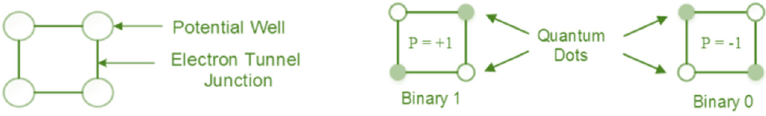
Figure 1. Basic QCA cell and its polarization states [27] .